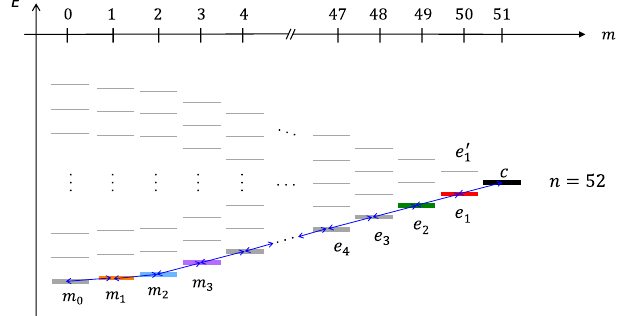
FIG. 1. Stark levels. Scheme of the energy levels for F ∼ 2 . 5 V = cm, sorted by m values for m ≥ 0 . The circular state is labeled c . The levels of the lower diagonal are labeled m j for low- m states and e j for high- m states. Finally, e 0 1 is the Stark level with m ¼ 50 above the circular state. The laser excitation prepares the m 2 state. The atom is then driven by a σ þ rf field ω σ þ field only at frequency ω n (blue arrows). Since a rf ¼ couples levels with Δ m ¼ þ 1 , the dynamics of the atom remains in the subspace of the manifold lower diagonal (levels repre- sented as thick lines).